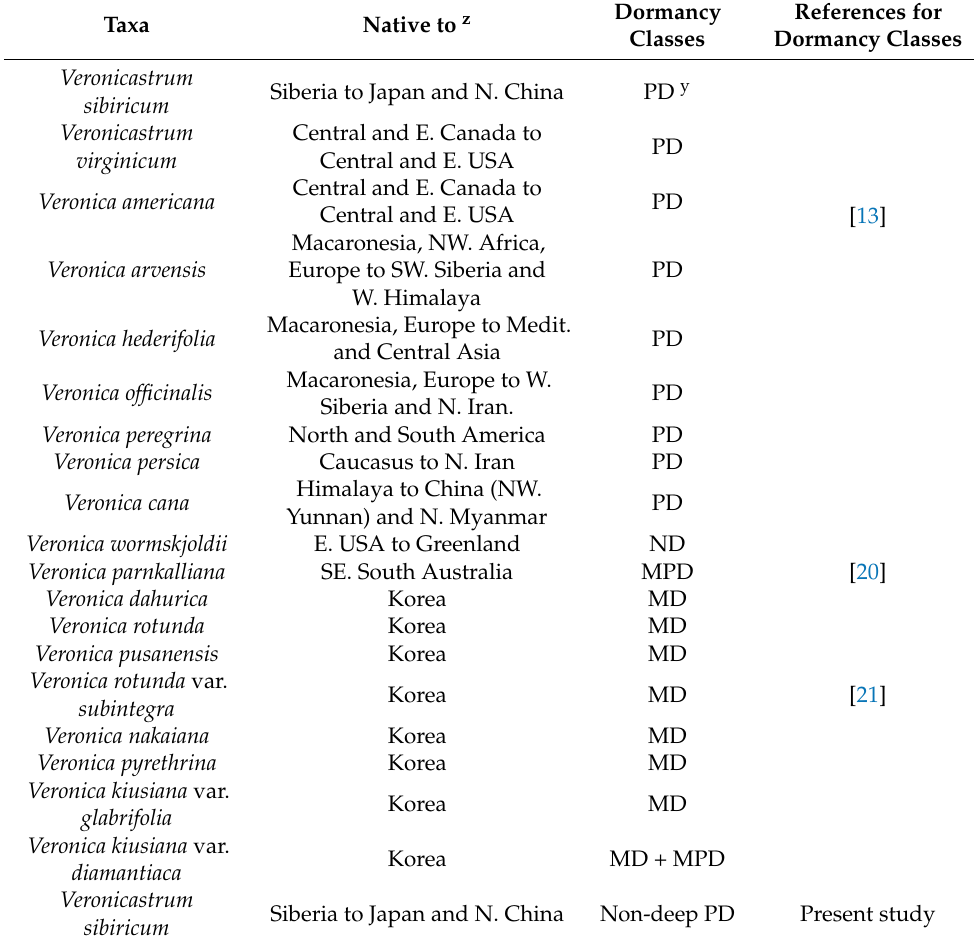
Table 2. Seed dormancy classes in Veronica and Veronicastrum